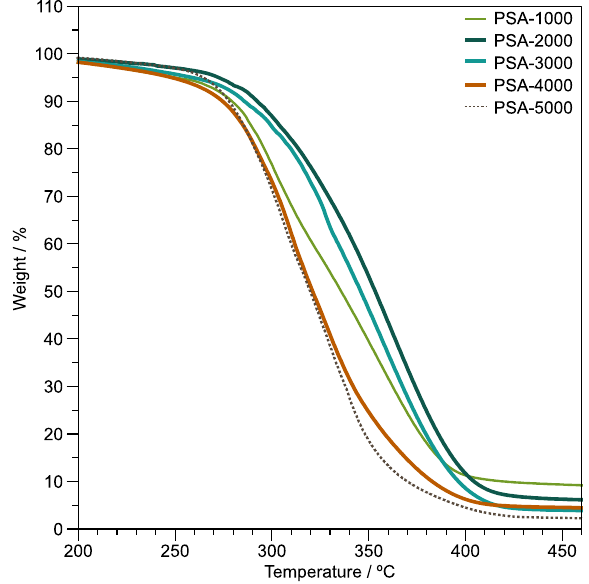
Figure 6. Thermogravimetric curves of PSA-1000, PSA-2000, PSA-3000, PSA-4000, and PSA-5000 films. Heating ramp = 10 °C/min, in an inert atmosphere.